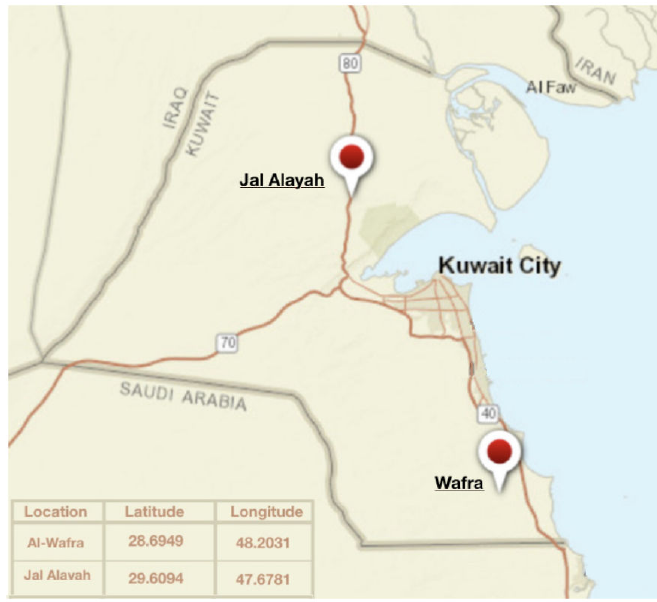
Figure 5. Two considered rural cell-site locations in